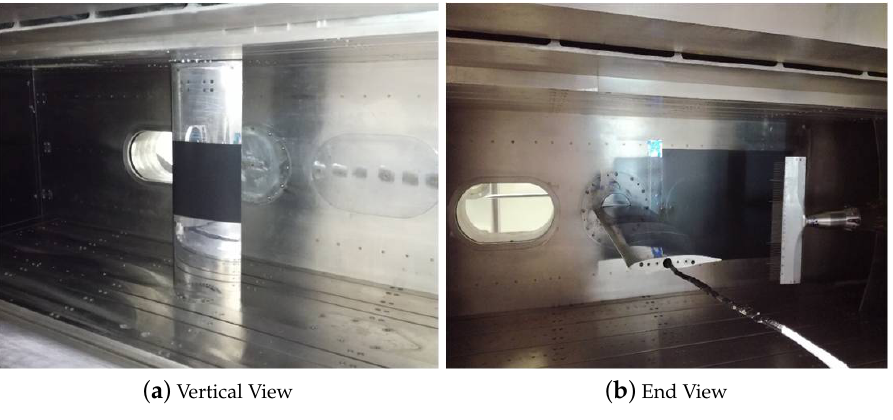
Figure 1. Photos of airfoil experimental